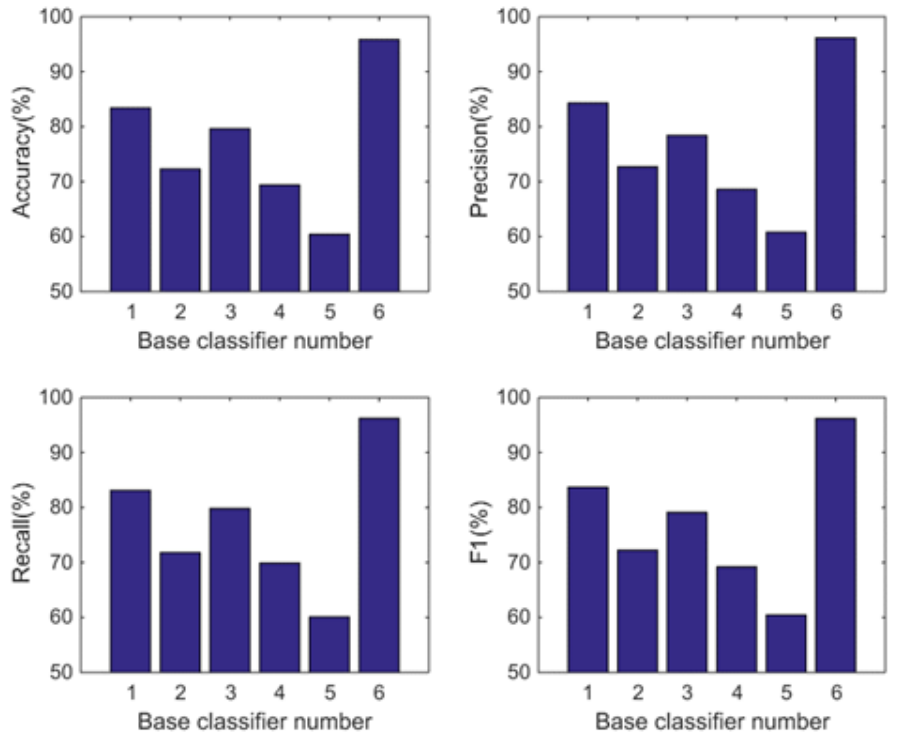
Figure 10. Performance comparison between base classifiers (1–5) and our fused classifier (6) for subject 1 in DSAD dataset.